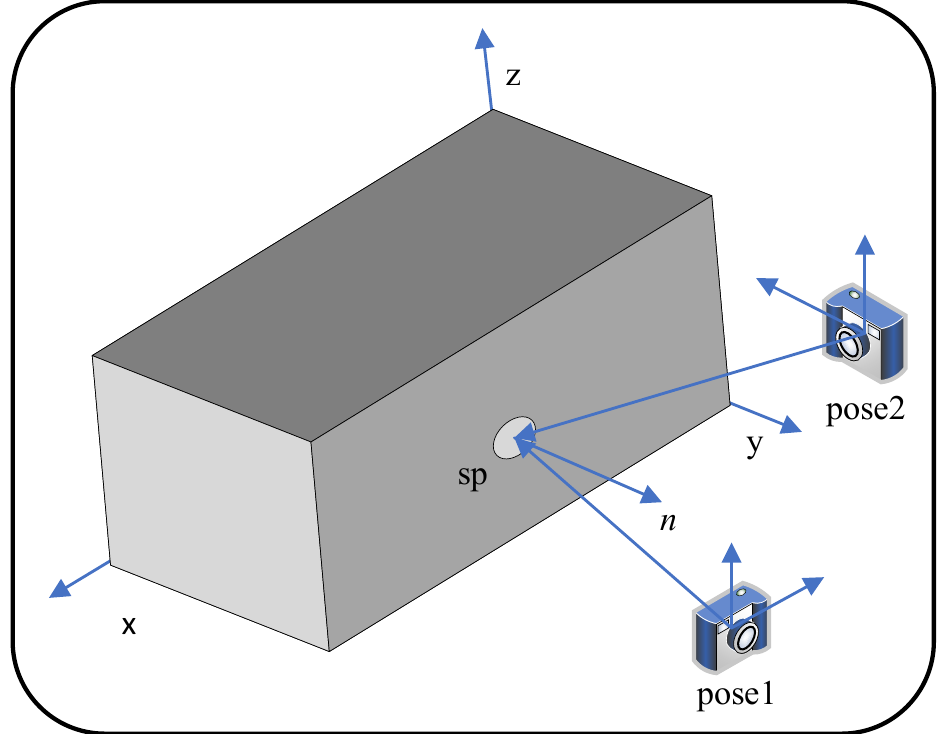
Figure 4. Best viewing angle. sp is a superpixel, and n is its normal. Pose 1 observes sp in a better view because of its smaller angle with the